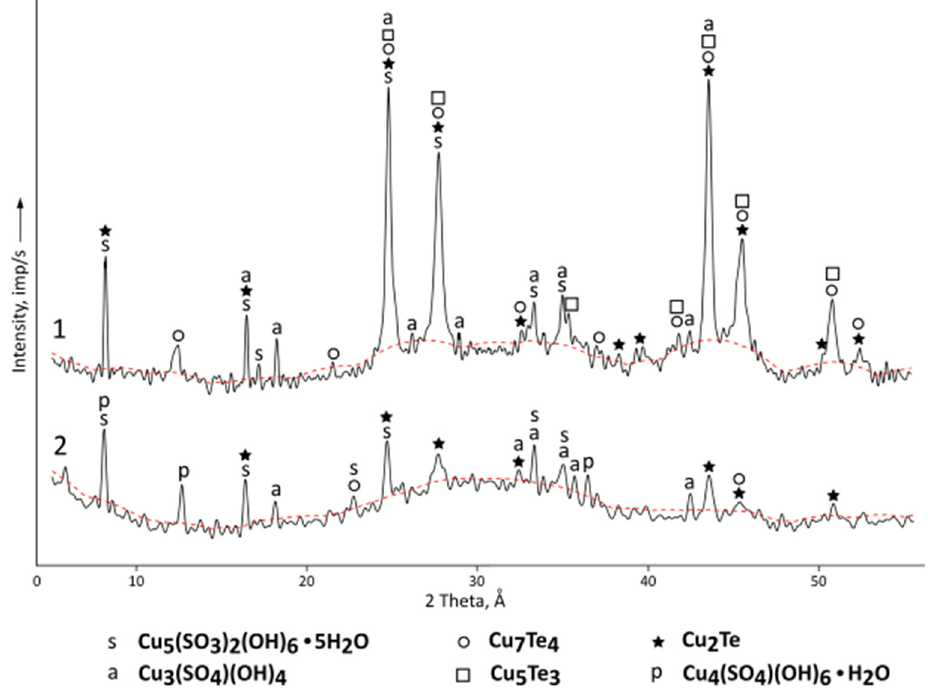
Figure 3. X-ray diffraction patterns of a tellurium-containing middling of Kazakhmys Corporation LLC: (1) at the time of delivery and (2) before studies.